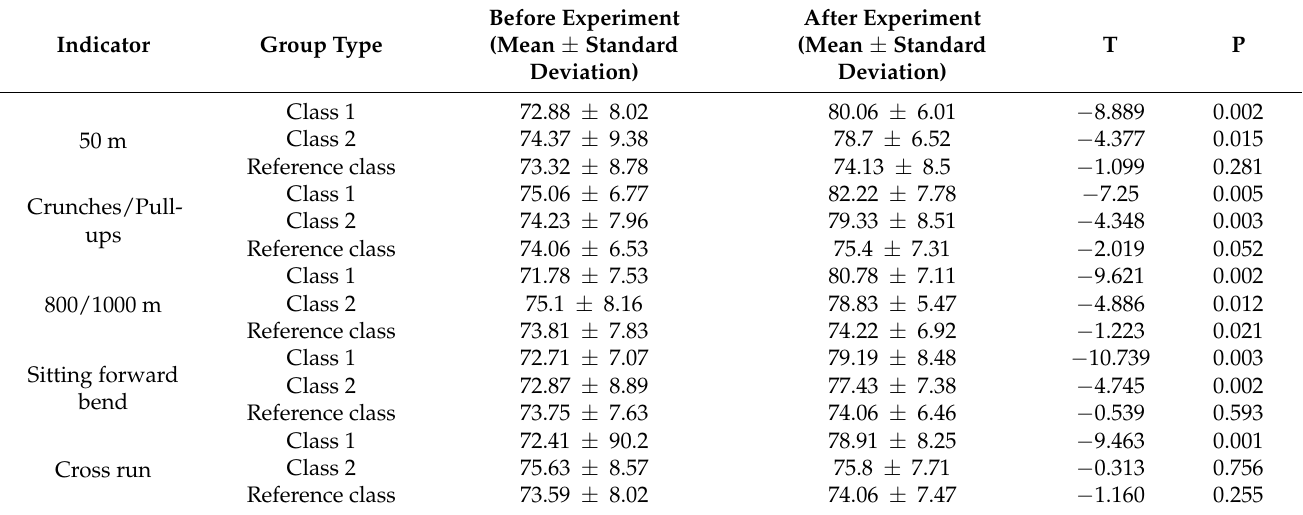
Table 5. Comparison and analysis table of various physical qualities of students in experimental class and control class before and after the